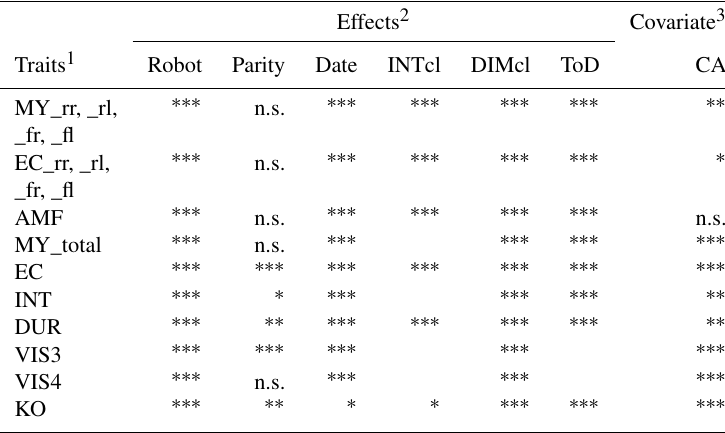
Table 2. Significance of fixed effects and of covariates for the different traits.